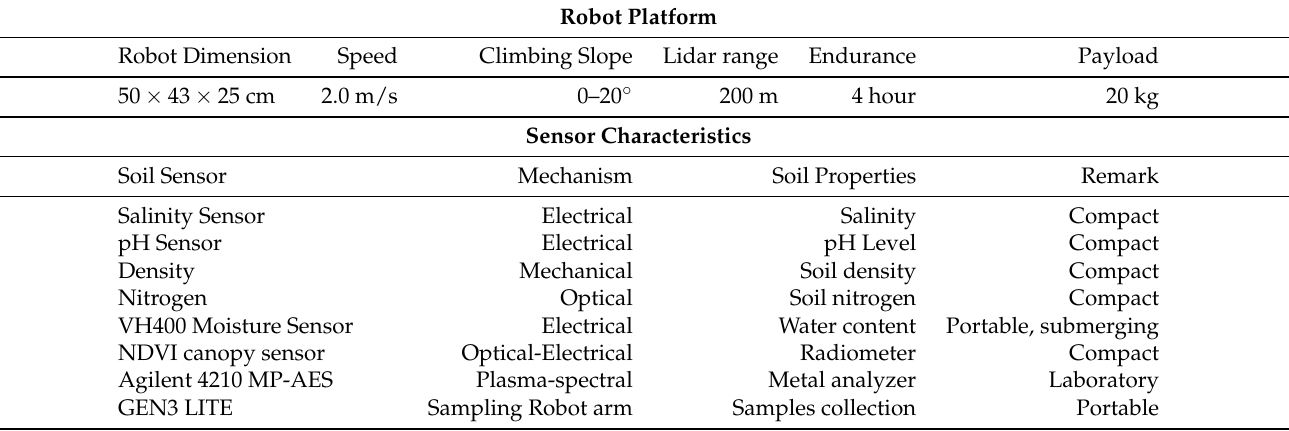
Table 1. Robot platform and sensor characteristics [15,41–48]. Robot